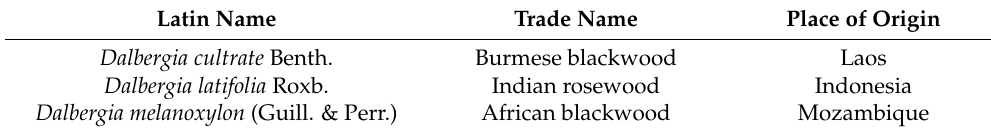
Table 4. Latin and trade names and places of origin of investigated Dalbergia species.